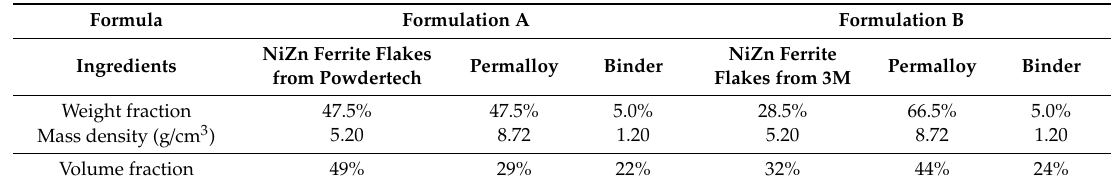
Table 1. Compositions of Formulations A and B.